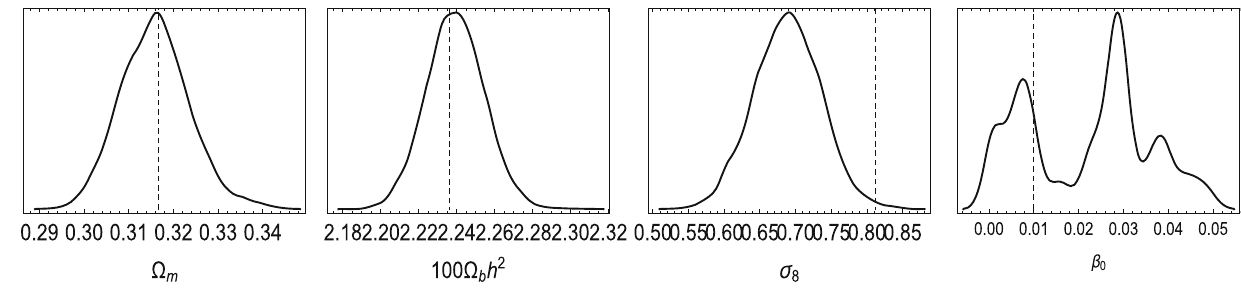
Fig. 2 One-dimensional PDF likelihood of the main cosmological parameters for the β -model used in this study. The vertical dashed lines connote the values of CMB Planck 2018 of TT,TE,EE+lowE on 68% interval for Ω m 0 ,Ω b 0 h 2 ,σ 8 . The last right panel also shows the degeneracies for the β 0 parameter. Fig. 3 Numerical solutions of the matter density evolution of each model. The left panel shows the comparison between Λ CDM, w CDM and β -model with the mean values of each model calculated from the MCMC chains as summarized in Table 3. The right panel shows a better visualization in logarithm scale of the comparison with these models by the ratio δ m i /δ m Λ CDM